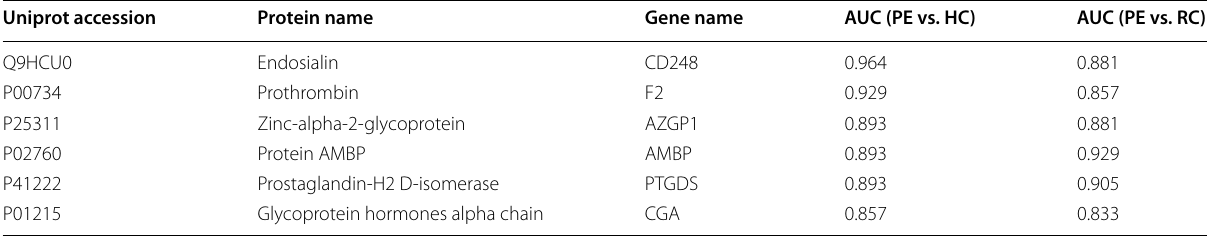
AUC Area under the curve, PE Preeclampsia, RC Risk controls, HC Healthy controls